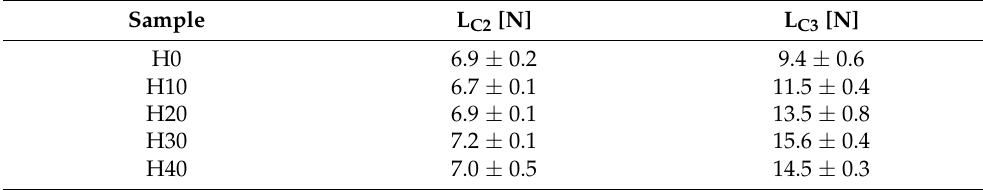
Figure 14. Images of scratch failures of the H0 ( a ), H10 ( b ), H20 ( c ), H30 ( d ), H40 ( e ) samples. Table 8. Critical loads for the studied coatings, determined by the scratch test.